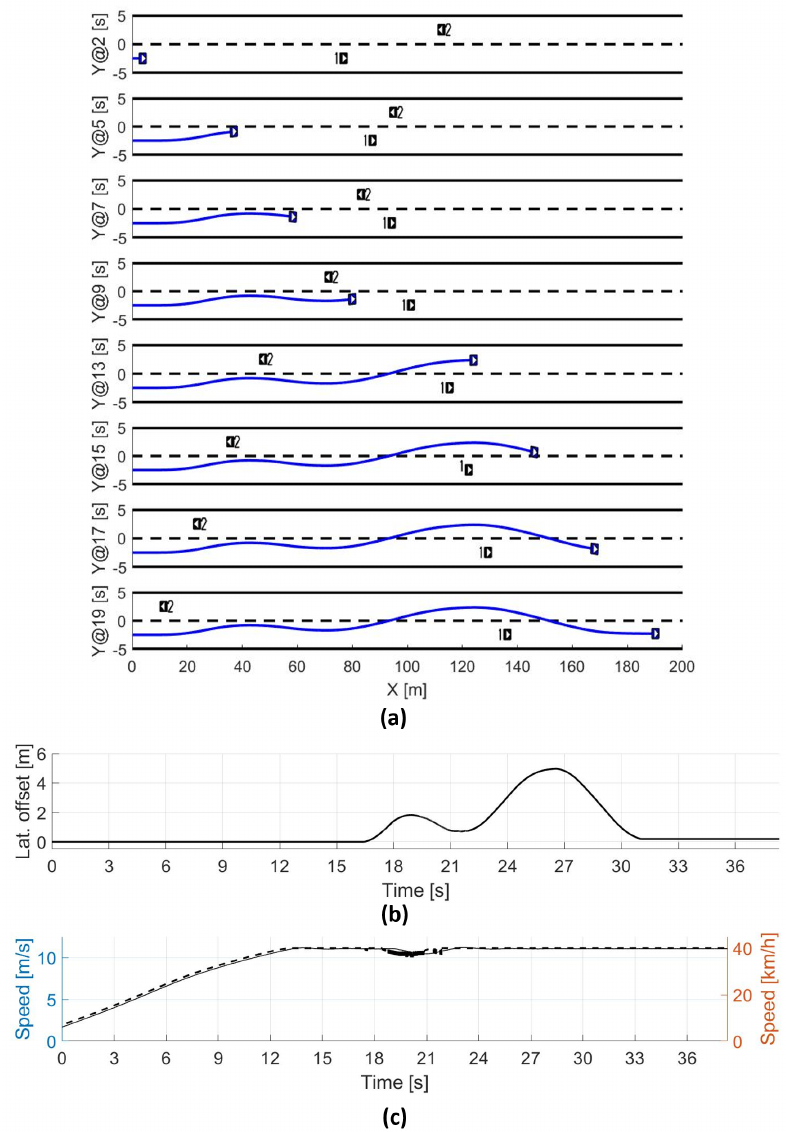
Figure 11. ( a ) Evolution of the scenario in time, ( b ) lateral offset for the overtaking maneuver, ( c ) ego vehicle speed during the